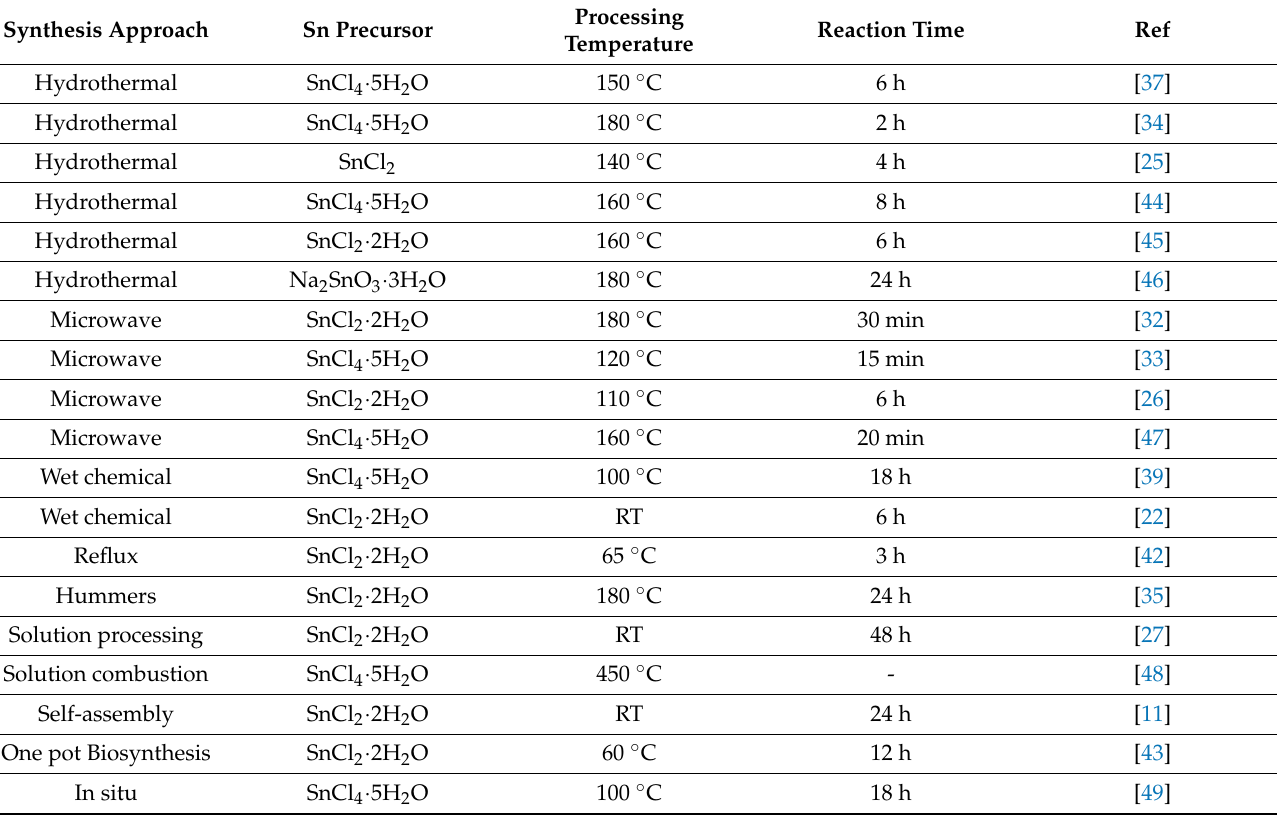
Table 1. SnO 2 quantum dot synthesis